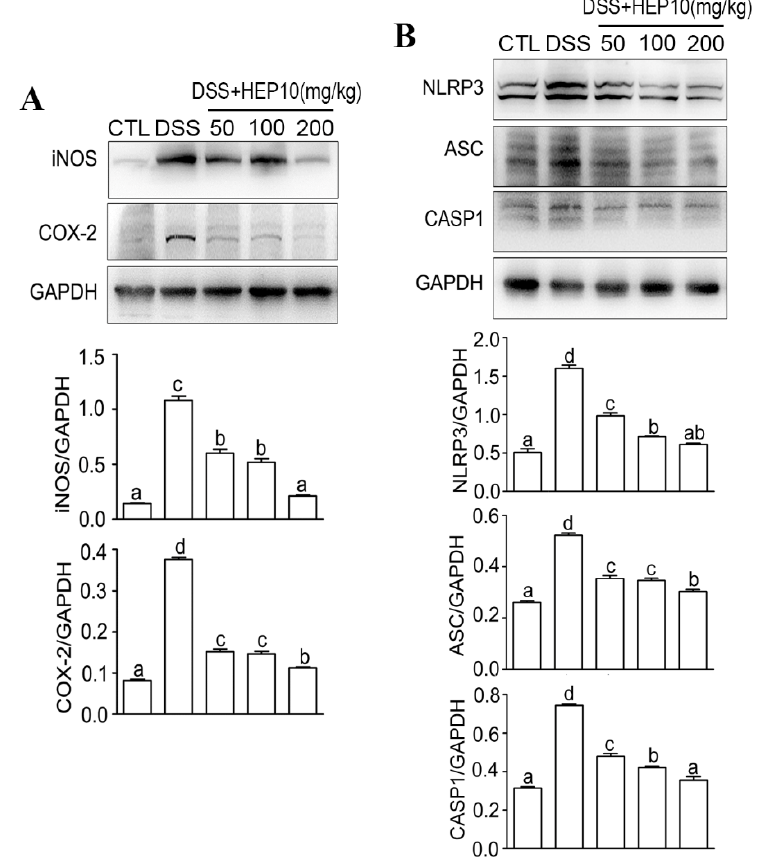
Figure 6. HEP10 inhibited the expression of iNOS, COX-2, and NLRP3 inflammasome in colon tissue of C57BL/6 mice with DSS-induced colitis. Western blot analysis of ( A ) iNOS, COX-2, ( B ) NLRP3, ASC, and CASP1 production. The data is presented as means ± SD ( n = 5). Different alphabetic letters refer to significant differences ( p < 0.05, two sided).